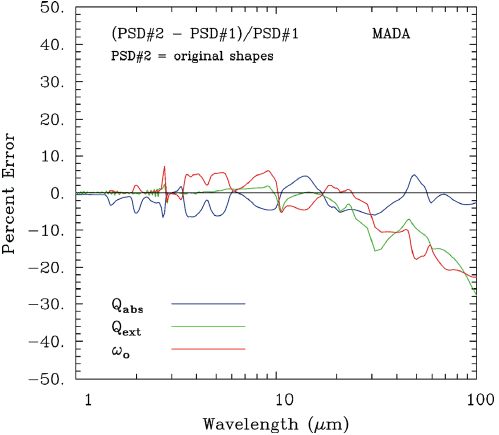
Figure 14. Wavelength dependence of optical property errors for PSD #2 in Fig. 11 (green Fig. 14. Wavelength dependence of optical property errors for PSD curve), relative to the measured PSD (PSD #1). Ice particle shape attributes are roughly the #2 in Fig. 11 (green curve), relative to the measured PSD (PSD #1). same in these two PSD. Ice particle shape attributes are roughly the same in these two PSD.